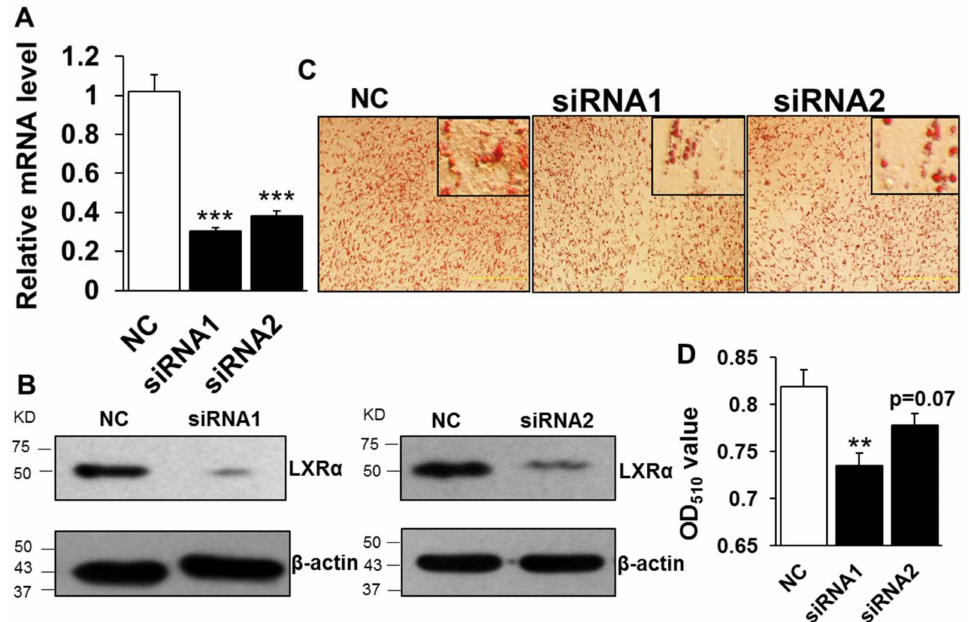
Figure 2. Knockdown of LXR α inhibits goat intramuscular adipocyte lipid accumulation. ( A , B ) The knockdown efficiency of LXR α at mRNA ( A ) and protein ( B ) level ( n = 6). ( C , D ) The Oil Red O staining ( × 100) and lipid accumulation between control and siRNAs treatment intramuscular adipocyte cells ( n = 6). ** p < 0.01, *** p < 0.001, compared to that of negative control (NC). Data are shown as the means ±